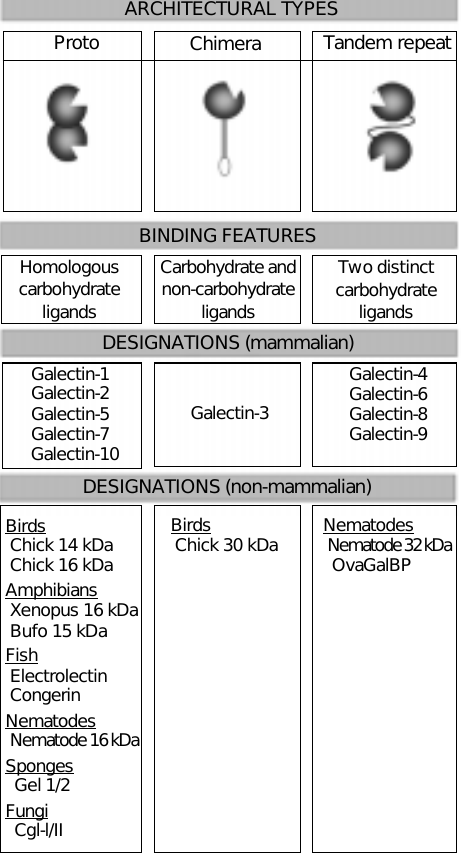
Figure 1 - Galectin family. Three architectural types and distribu- tion in mammalian and non- mammalian